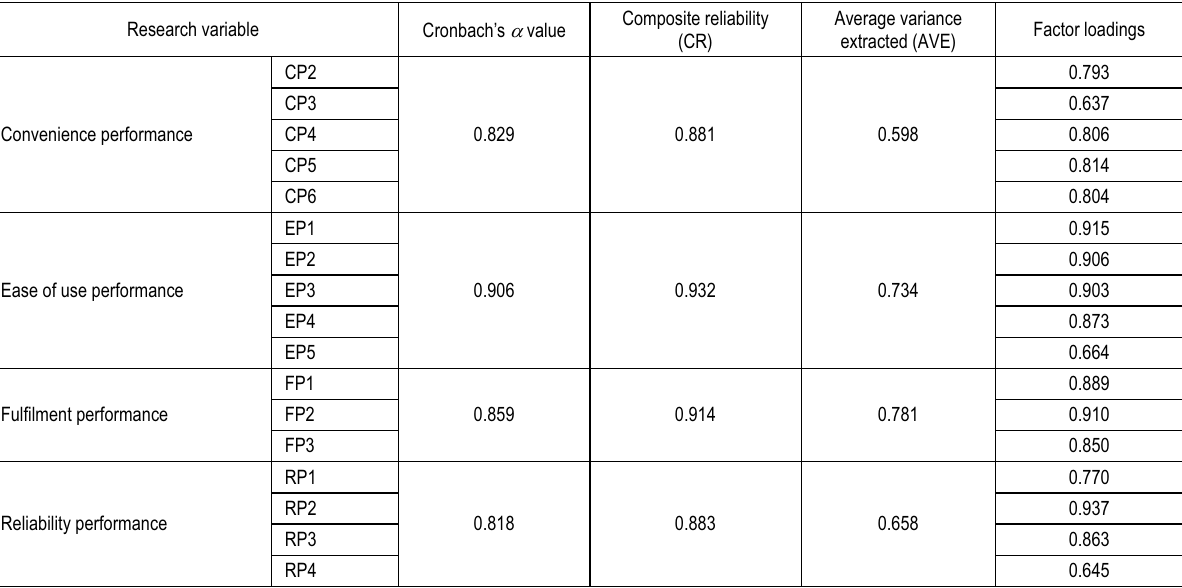
Table 1. Scale reliability